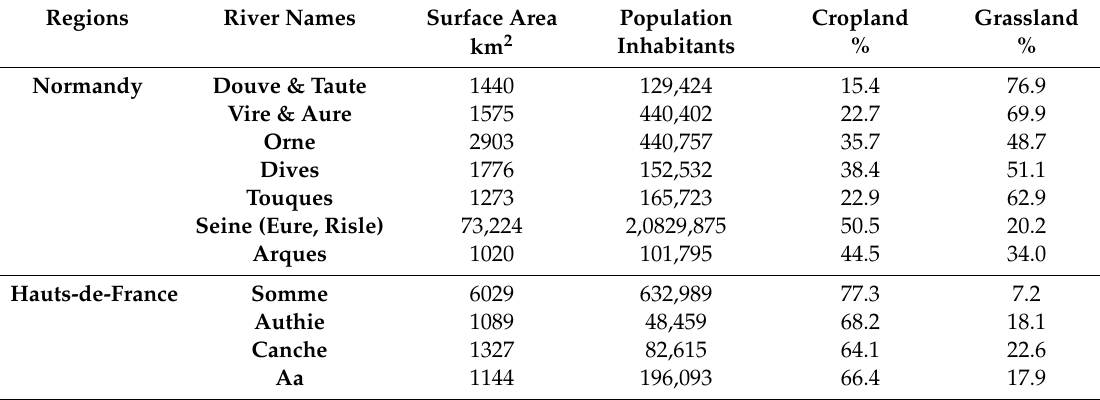
Table 2. General characteristics of the watersheds